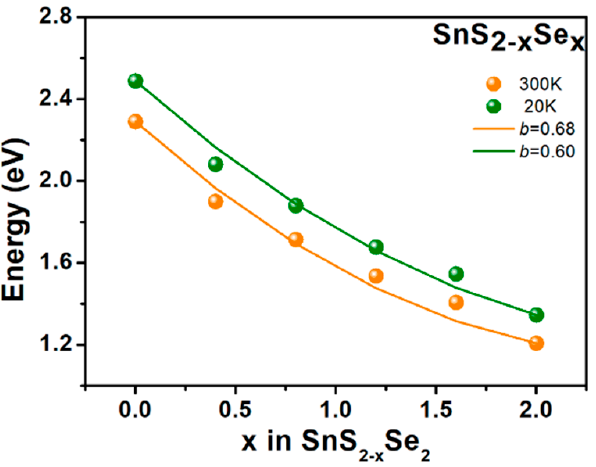
Figure 4. Composition dependent excitonic transition energies for SnS 2-x Se x layered crystals at 300 K. The solid curves are least-squares fits to Equation (2).